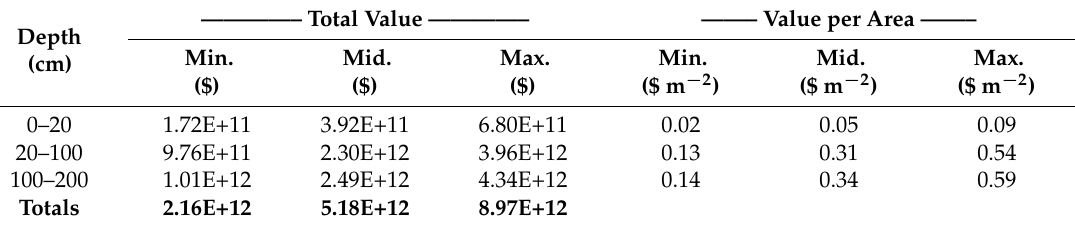
Table 2. Total SIC value and area-averaged value by depth for the contiguous United States based on [9] and a 2014 U.S. average price of $10.42 per U.S. ton of agricultural limestone